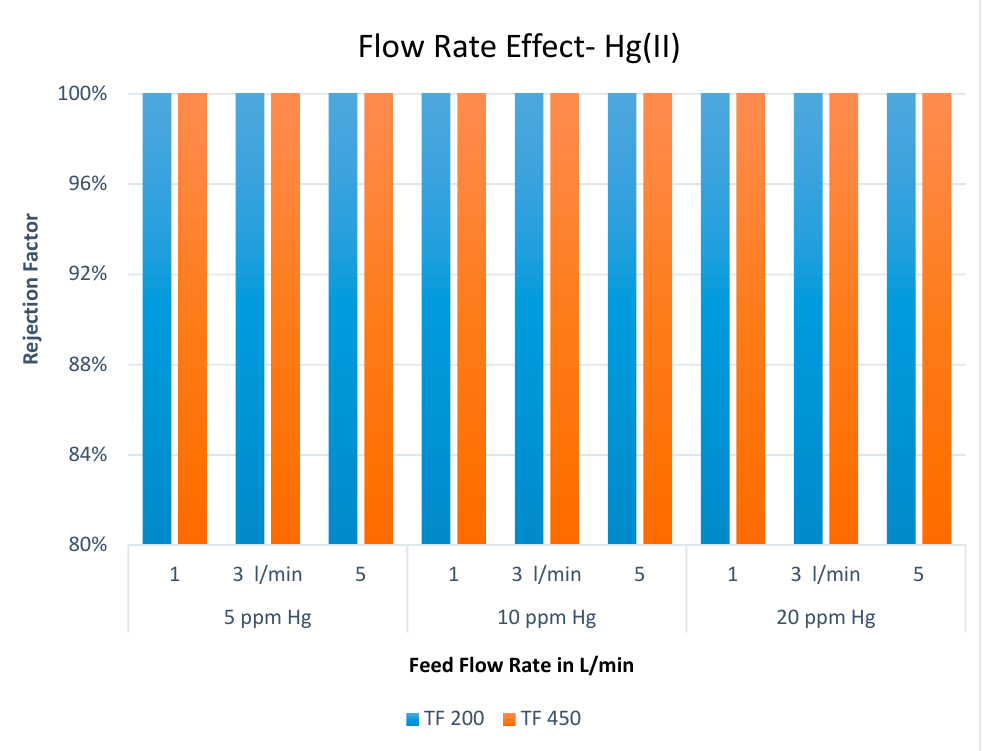
Figure 5. Effect of feed flow rate on the rejection factor using TF200 and TF450 membranes for Hg(II) (feed temperature = 50 °C, condensing temperature = 10 °C).